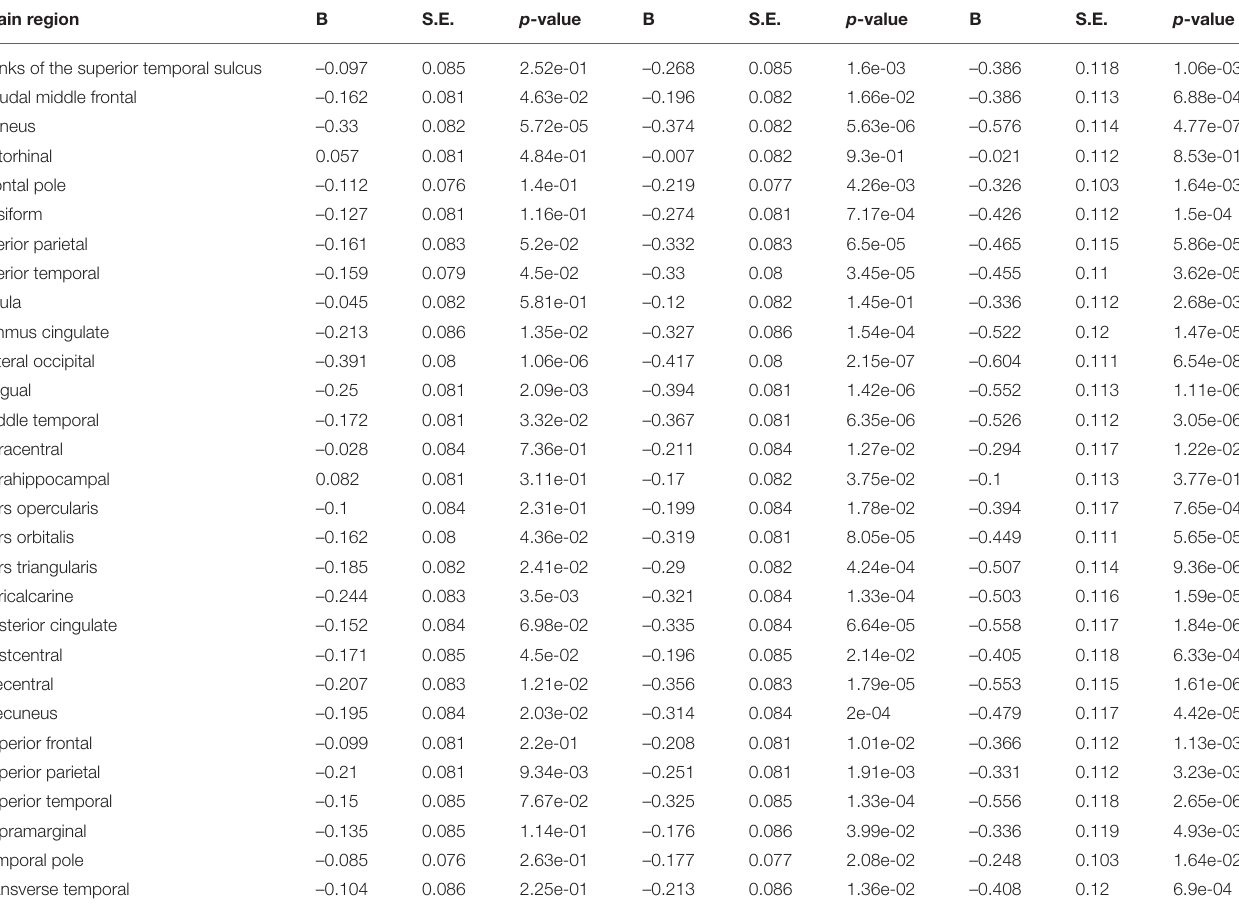
TABLE 7 | Exploratory surface area model